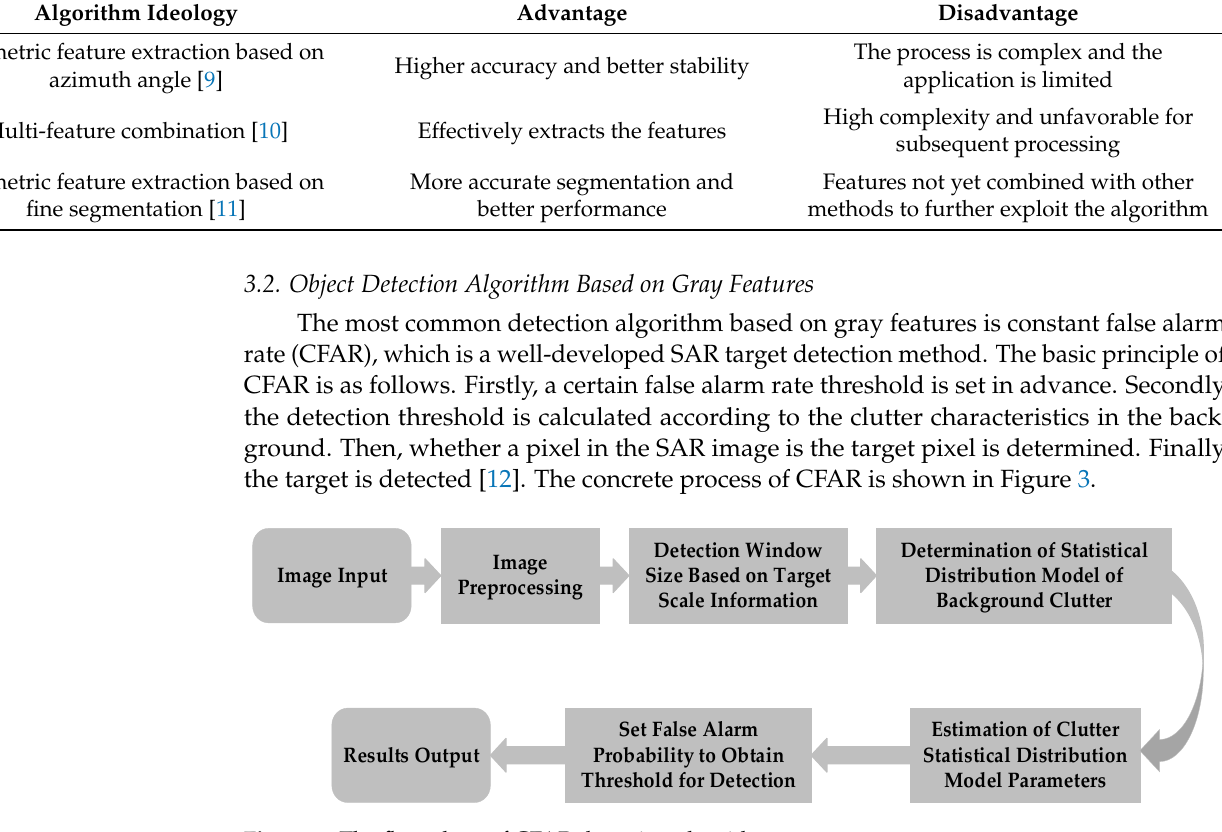
Figure 3. The flow chart of CFAR detection algorithm.